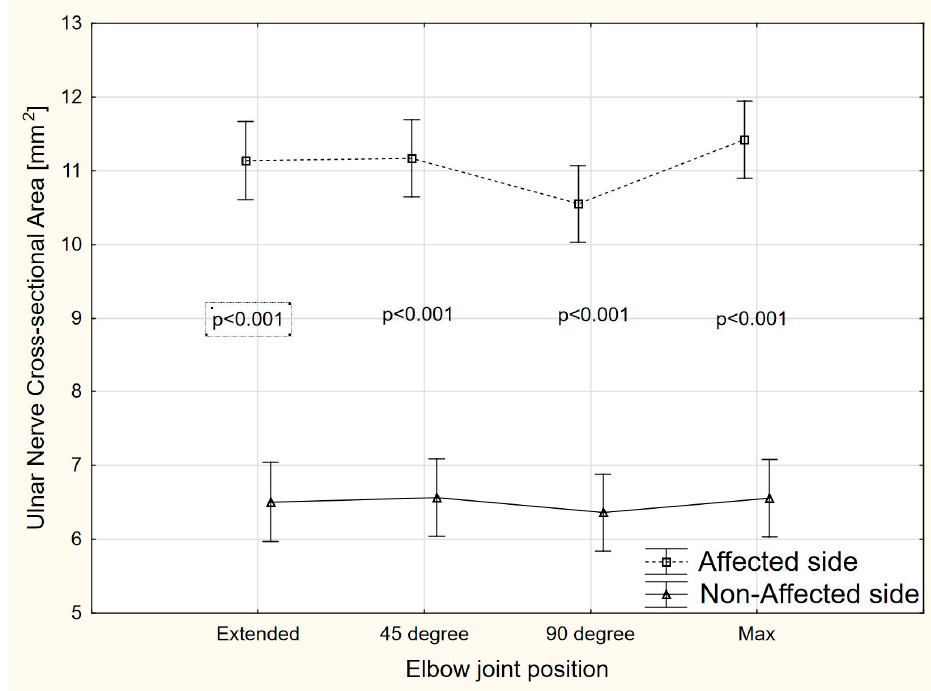
Figure 4. The CSA changes in different positions of the elbow joint. 3.4. Trace There were significant side-to-side differences (ANOVA, F = 54.2, p < 0.001) in the ulnar nerve TRACE value at each elbow position (extended, 45°, 90°, and maximal elbow flexion) (Figure 5). Compared to the non-affected side, the mean TRACE on the affected side was higher by 1.76 mm (95% CI 1.14–2.12), 1.74 mm (95% CI 1.38–2.11), 1.93 mm (95% CI 1.56–2.29), and 1.54 mm (95% CI 1.18–1.90) for extended elbow, 45° of elbow flexion, 90° of elbow flexion, and maximal elbow flexion, respectively.